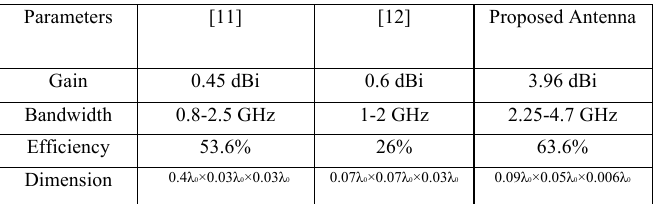
Table 1. Dimensions and radiation characteristics of the some of the conventional antennas in comparison to the proposed